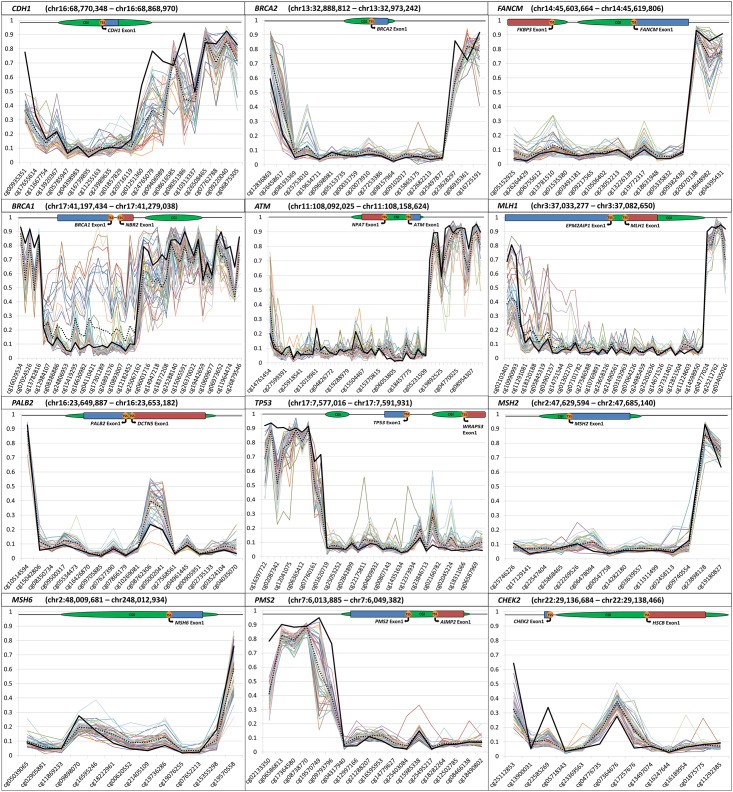
Sample tumor DNA methylation across a panel of tumor suppressor genes.Plotted β-values at CpG probes across defined genomic regions. Each colored line indicates β-values for an individual tumor-derived DNA sample. Solid black line indicates average β-values for blood-derived DNA. Dotted black line indicates average β-values for tumor-derived DNA. Gene region schematics denote [CGI (CpG Island), TSS (Transcriptional Start Site)].